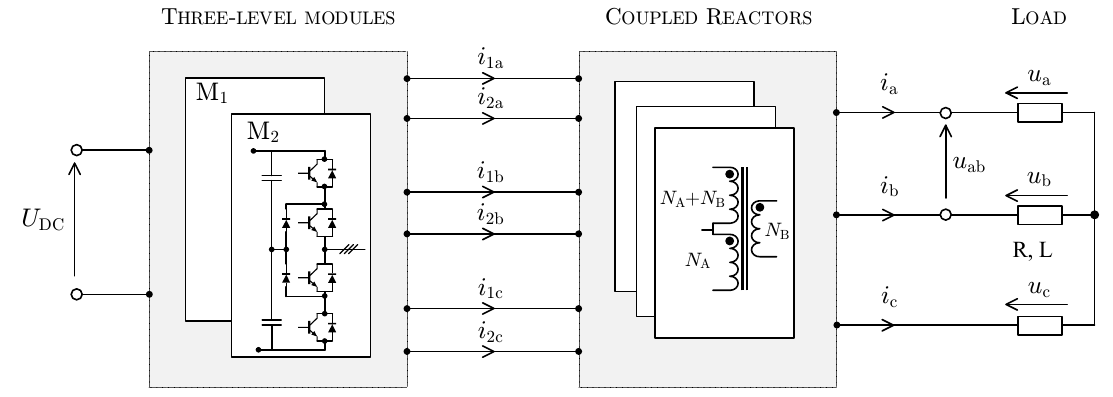
Figure 8. Twelve-pulse modular VSI with coupled reactors and three-level